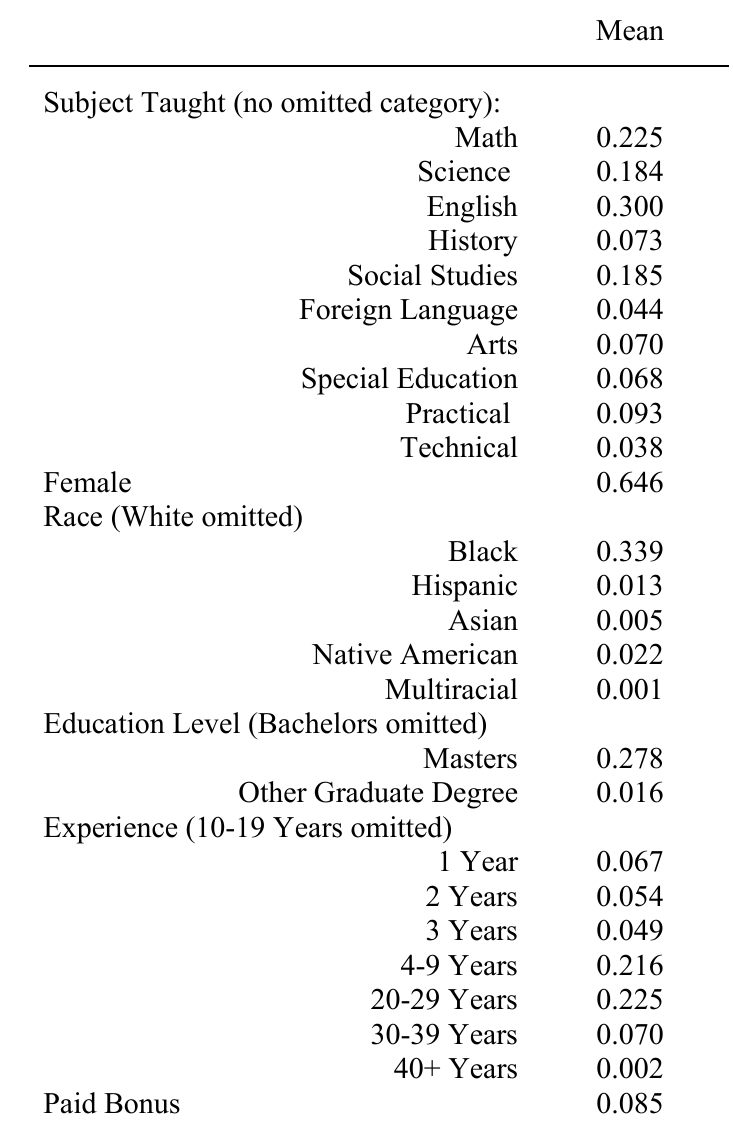
Table 2 : Teacher-Year Level Summary